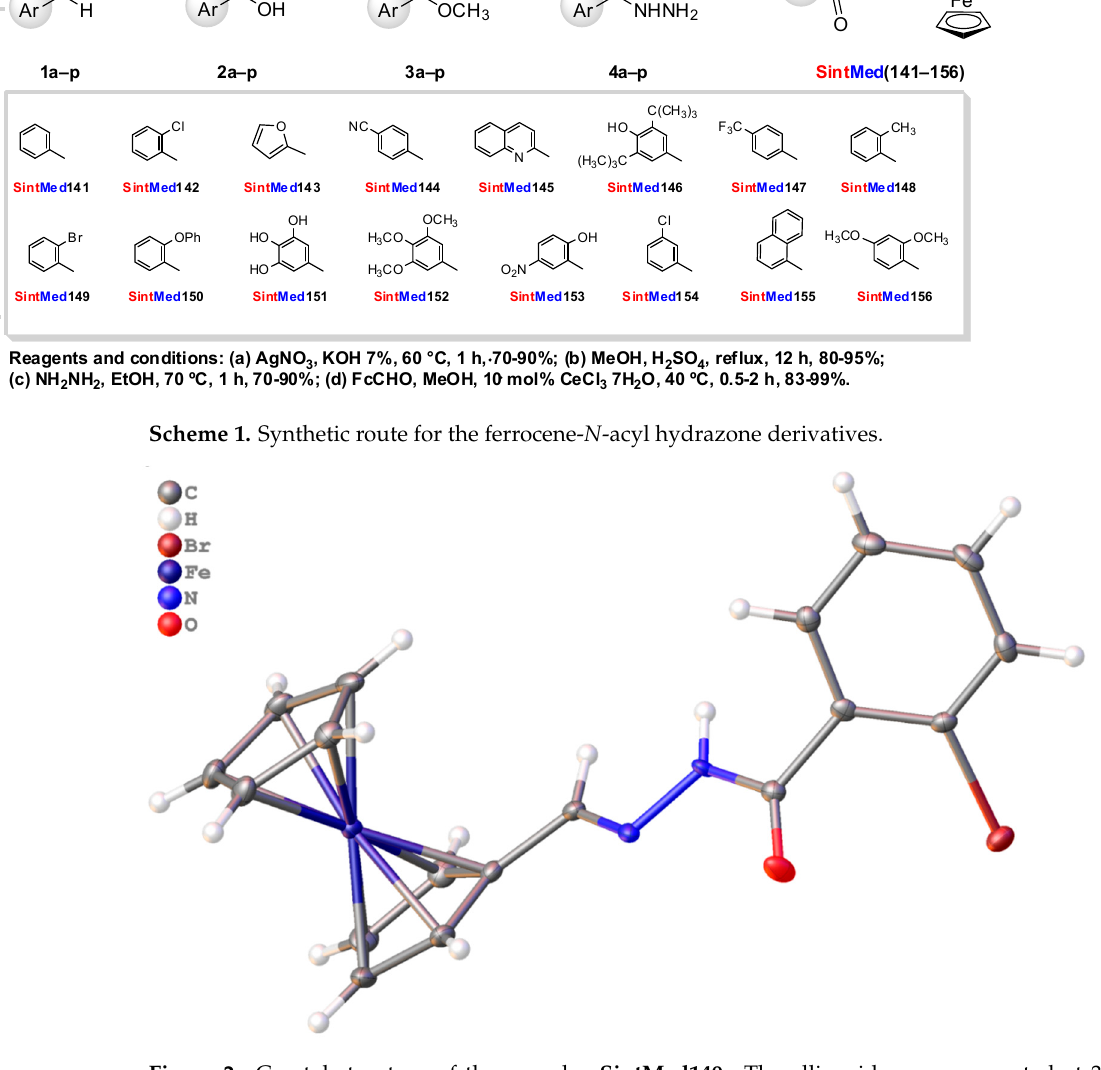
Figure 2. Crystal structure of the complex SintMed149 . The ellipsoids are represented at 30% of probability.